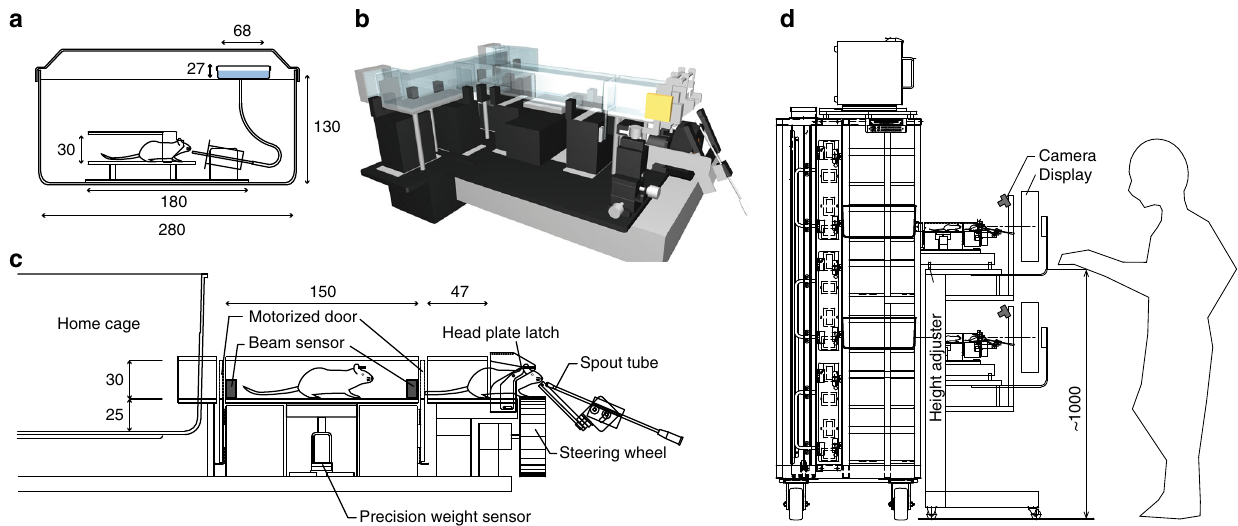
Fig. 1 High-throughput automated setup for voluntary head fi xation. a Head-restraining habituation system. Depiction of a mouse inside a transparent PVC tube drinking water from a water spout connected to a water tank (blue box). Narrowing rails on the sides of the tube progressively restrain the head-post (details in Supplementary Fig. 1). There is no latching mechanism for the head-post, hence mice can back out of the tube at any time. The containing box represents a mouse cage with an air- fi ltering lid and a metal grid for mouse containment (horizontal solid line under the lid) as in standard individually ventilated cages. Over the course of a couple of days, mice routinely self-restrained to drink water. b 3D view of the main dual cage setup (details of all hardware and software components in the Supplementary Material). c Side view of setup and labeling of its main components. d Side view of two setups (training capability of a single setup is four mice/day) housed in a mouse rack. Several setups can be accommodated in the same rack (current capacity: 12 platforms, 48 mice/day, ~12,000 trials/day). All units are in mm. Original technical drawings edited with permission from O ’ Hara & Co.,